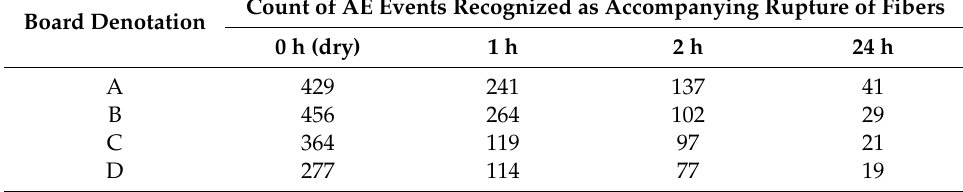
Table 6. Registered AE events recognized as accompanying rupture of fibers during three-point bending. Board